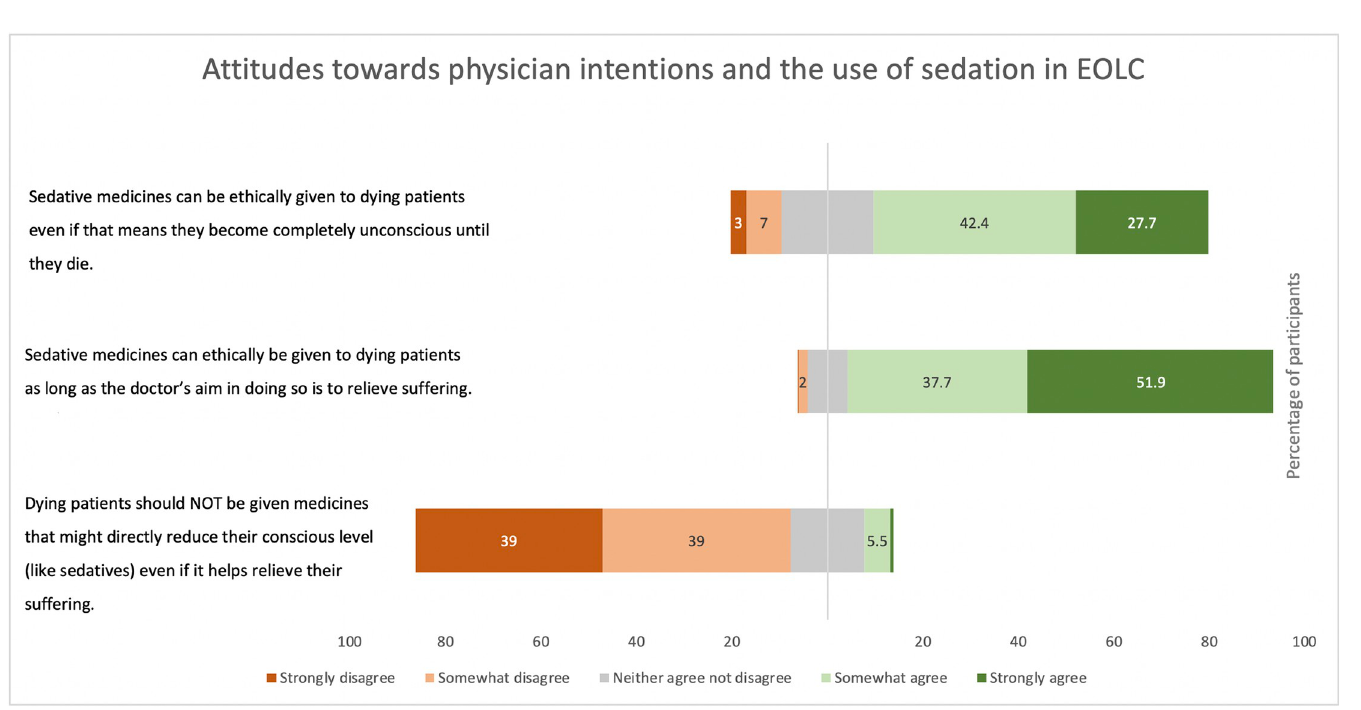
Ethical to offer patients.